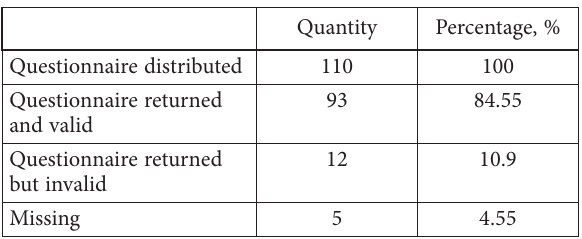
Table 3. Sample characteristics